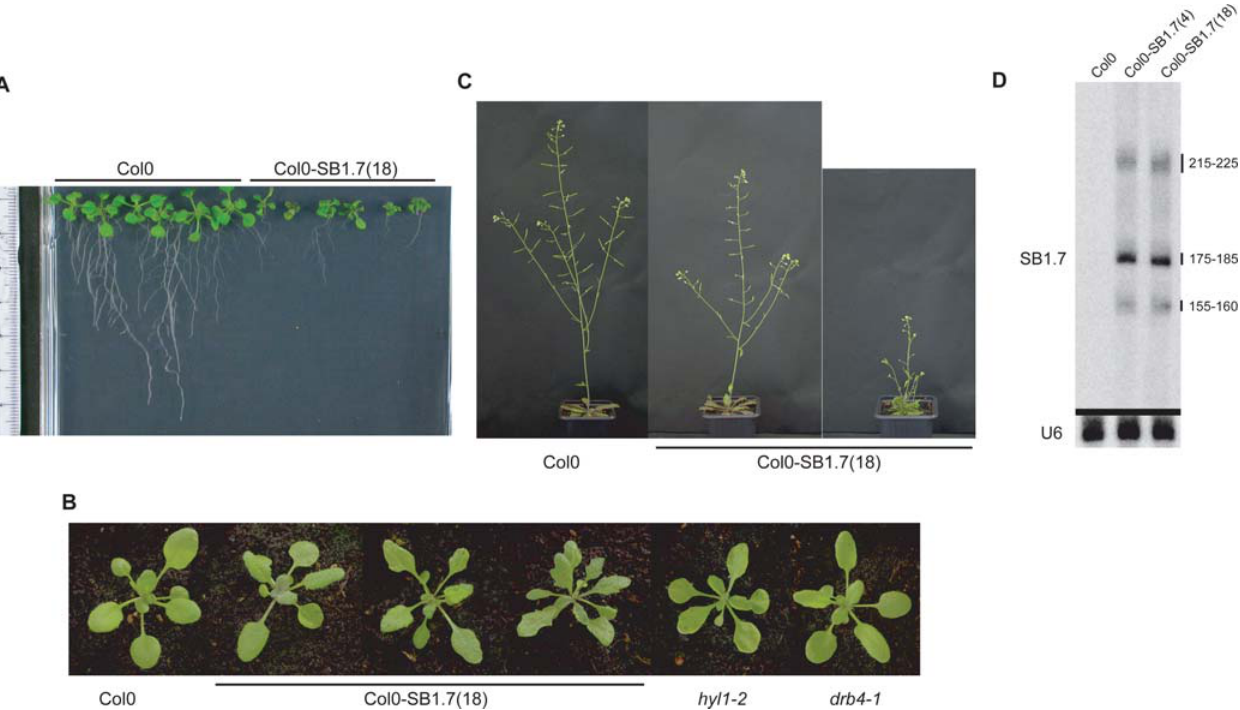
Figure 1. Description of the SINE-induced phenotype. Different individuals from the Col0-SB1.7(18) transgenic line producing SB1 RNA are compared to wild type (Col0) plants. A. Impact on root growth. Col0-SB1.7(18) individuals have much shorter roots compared to the wild type. Six different Col0-SB1.7(18) individuals representing the variability in this line are presented B. Comparison of 27 days seedlings from Col0, Col0-SB1.7(18) and hyl1-2 , drb4-1 RNAi mutant lines. Leaves from Col0-SB1.7(18) individuals are narrower, irregular in shape, and present a downward curvature. Three different Col0-SB1.7(18) individuals representing the variability in this line are presented. C. Col0-SB1.7(18) individuals have a general delayed growth, present shorter siliques and suffer from a partial loss of apical dominance. Two different Col0-SB1.7(18) individuals representing a mild and a severe case are presented. D. Typical pattern of SB1.7 SINE expression obtained by PAA gel hybridization after an 18h exposure. Three SB1.7-specific RNA species were detected, as expected from the post-transcriptional processing of the SINE primary transcript [28]. The sizes (in nucleotides) of the hybridizing SINE RNA species are shown. Following stripping of the probe, the membrane was re-hybridized with a U6-specific probe and exposed for 10